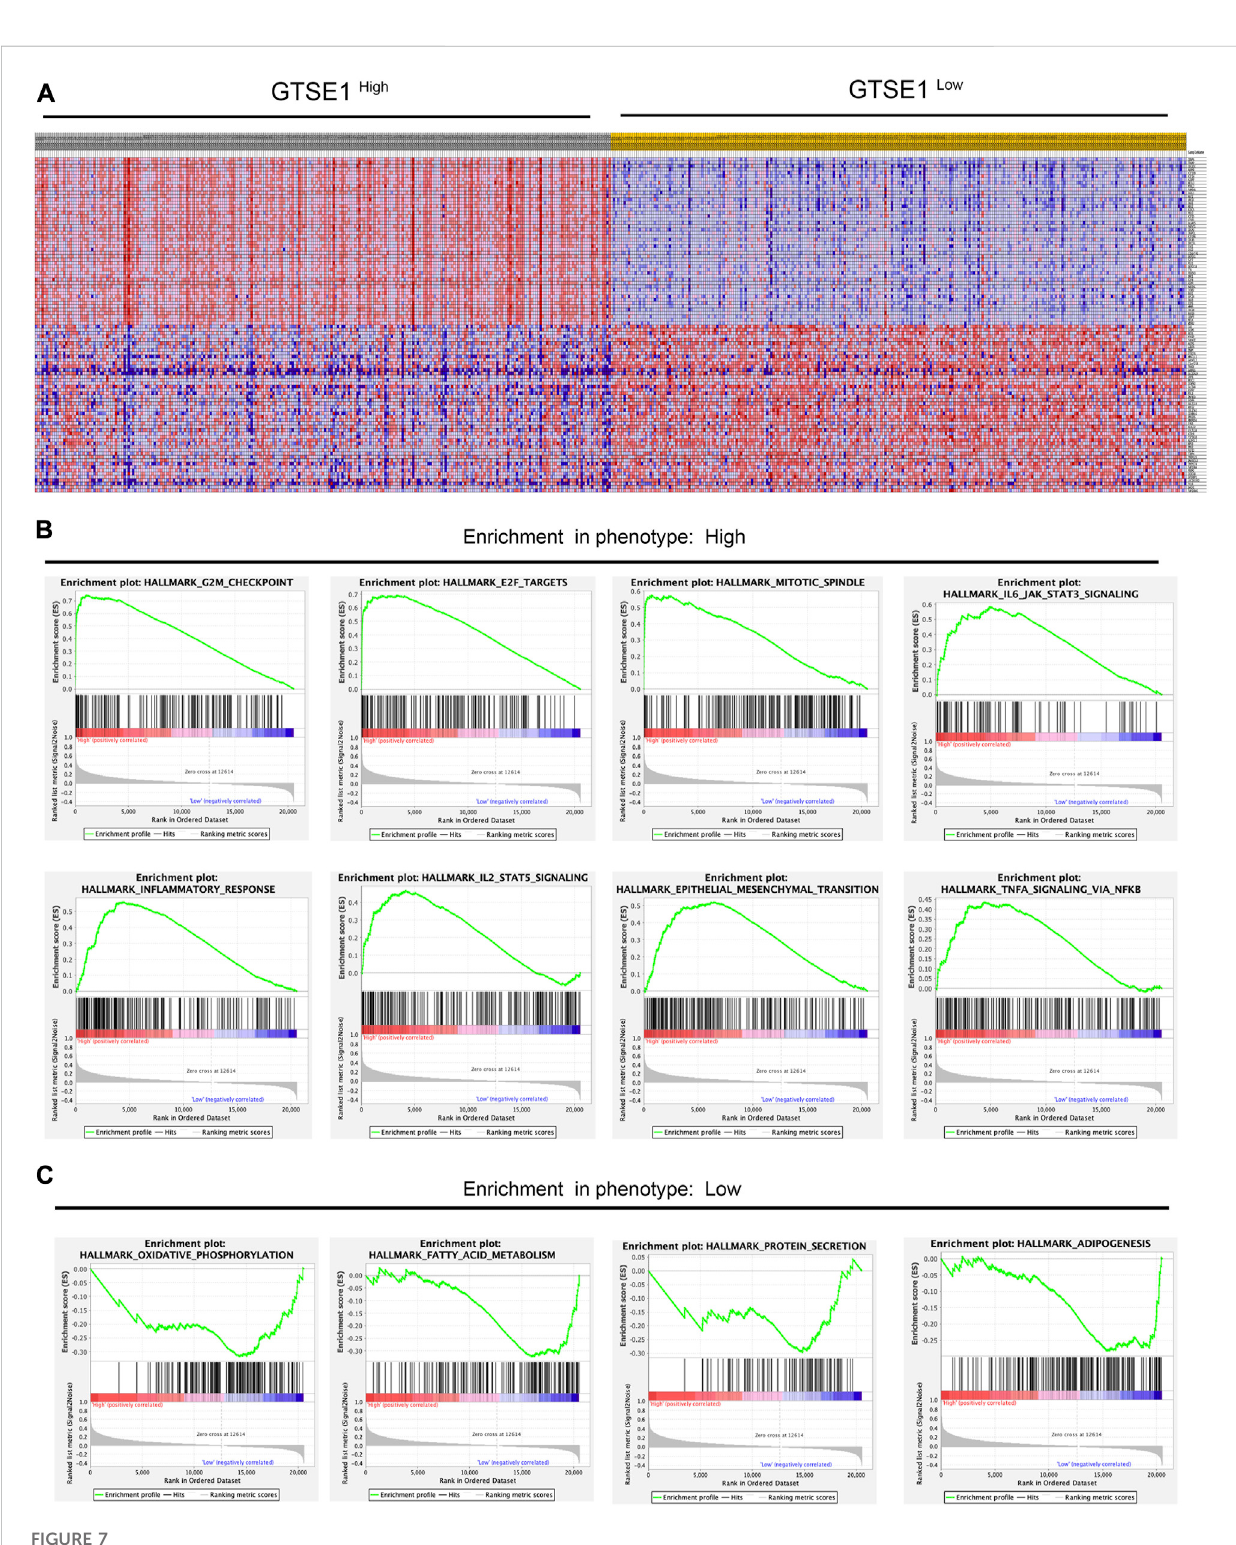
FIGURE 7 GSEAofGTSE1intheTCGA-KIRCdatasetandthesigni fi cantlychangedpathwaysin50hallmarkgenesetsbasedonGTSE1expression. (A) Heatmaps of the top 100 genes upregulated or downregulated in the GTSE1 high-expression group and GTSE1 low-expression group in ccRCC patients. (B) GSEA displayed the most signi fi cantly upregulated signaling pathways enriched in the GTSE1 high-expression group. (C) GSEA displayed the most signi fi cantly downregulated signaling pathways enriched in the GTSE1 low-expression